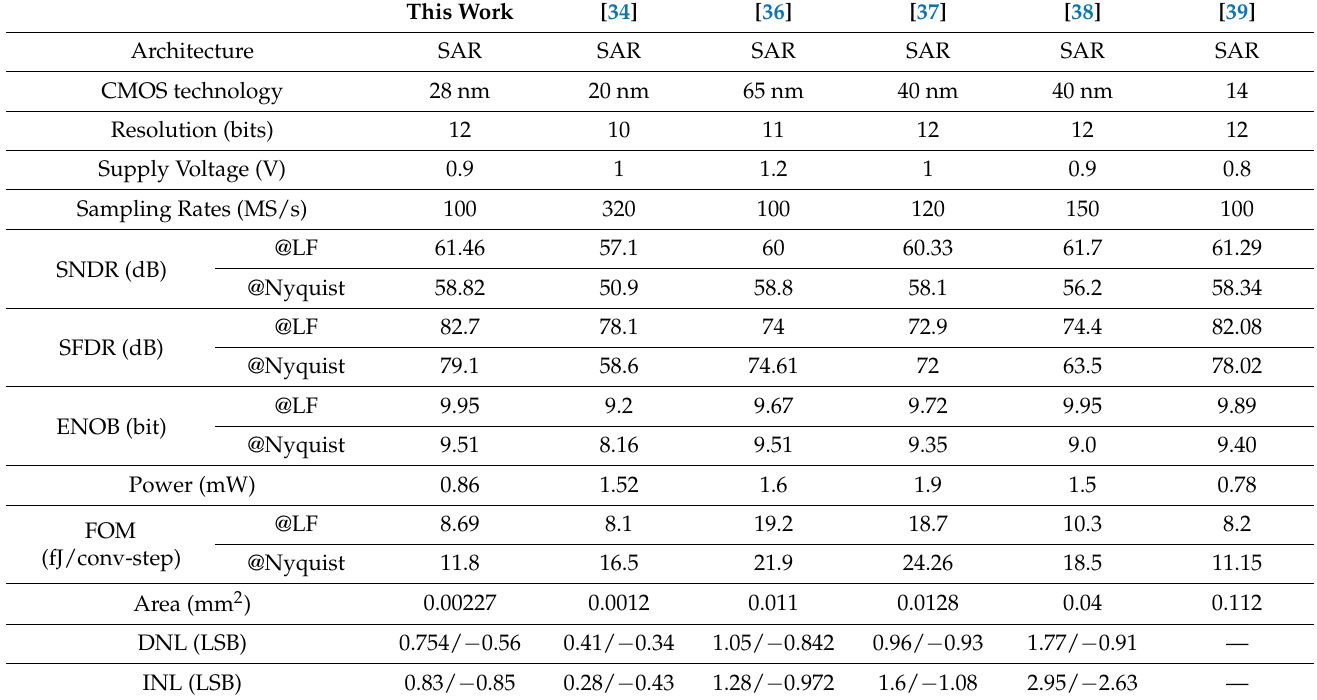
Table 2. Performance summary and